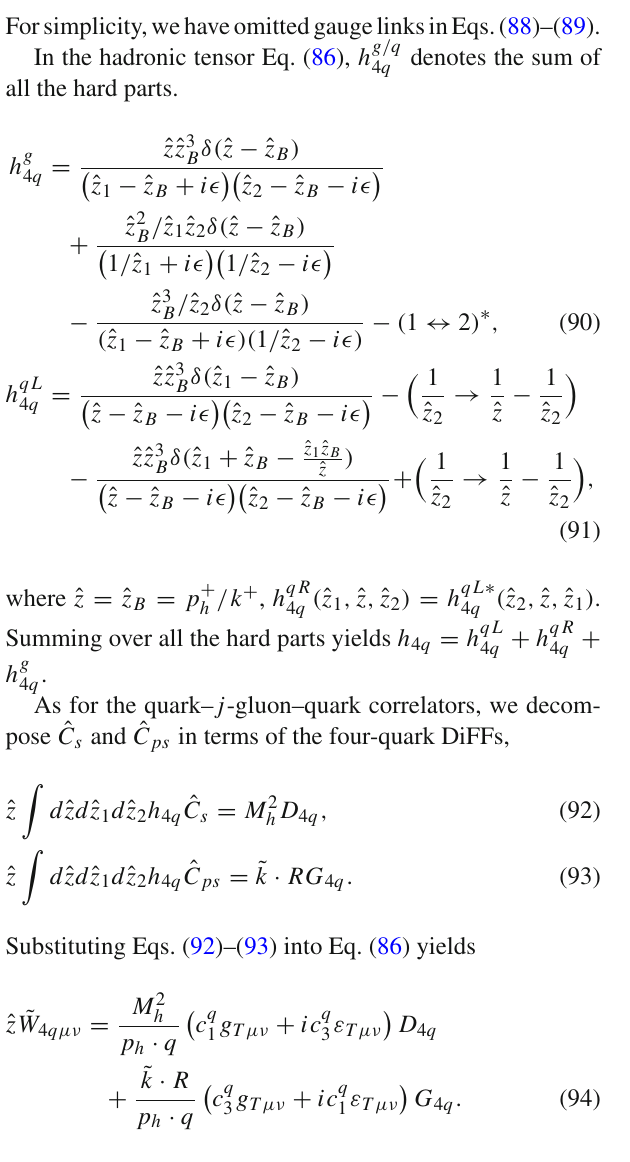
Fig. 4 The first four of the four-quark diagrams where no multiple gluon scattering is involved. In ( a ), we have k (cid:4) ( b ) we have the interchange of k 1 with k (cid:4) k